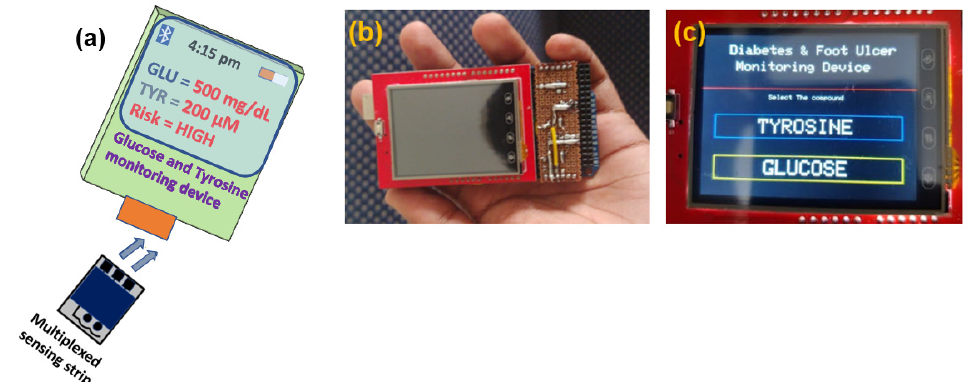
Figure 5. Snapshots of ( a ) integration of multiplexed sensing strip with portable device; ( b ) actual image of portable palm-sized device; ( c ) the display unit of the detection module.